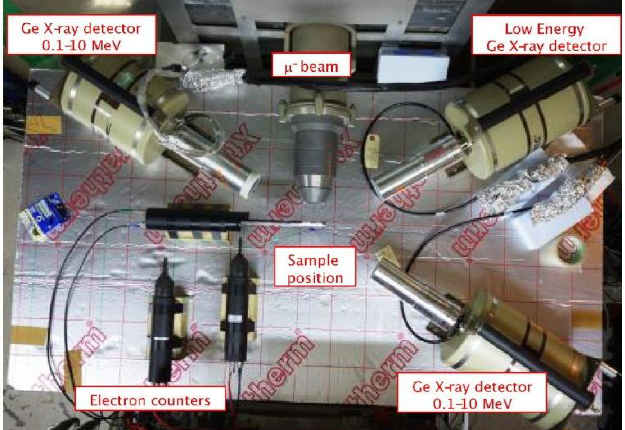
Figure 6. The experimental setup at the ISIS muon facility. Thanks to the flexibility of the experi- mental setup (i.e., the detectors being easily moved), samples of different shapes and sizes can be measured. The figure was taken and adapted with permission from Ref. [7] © 2016, Elsevier